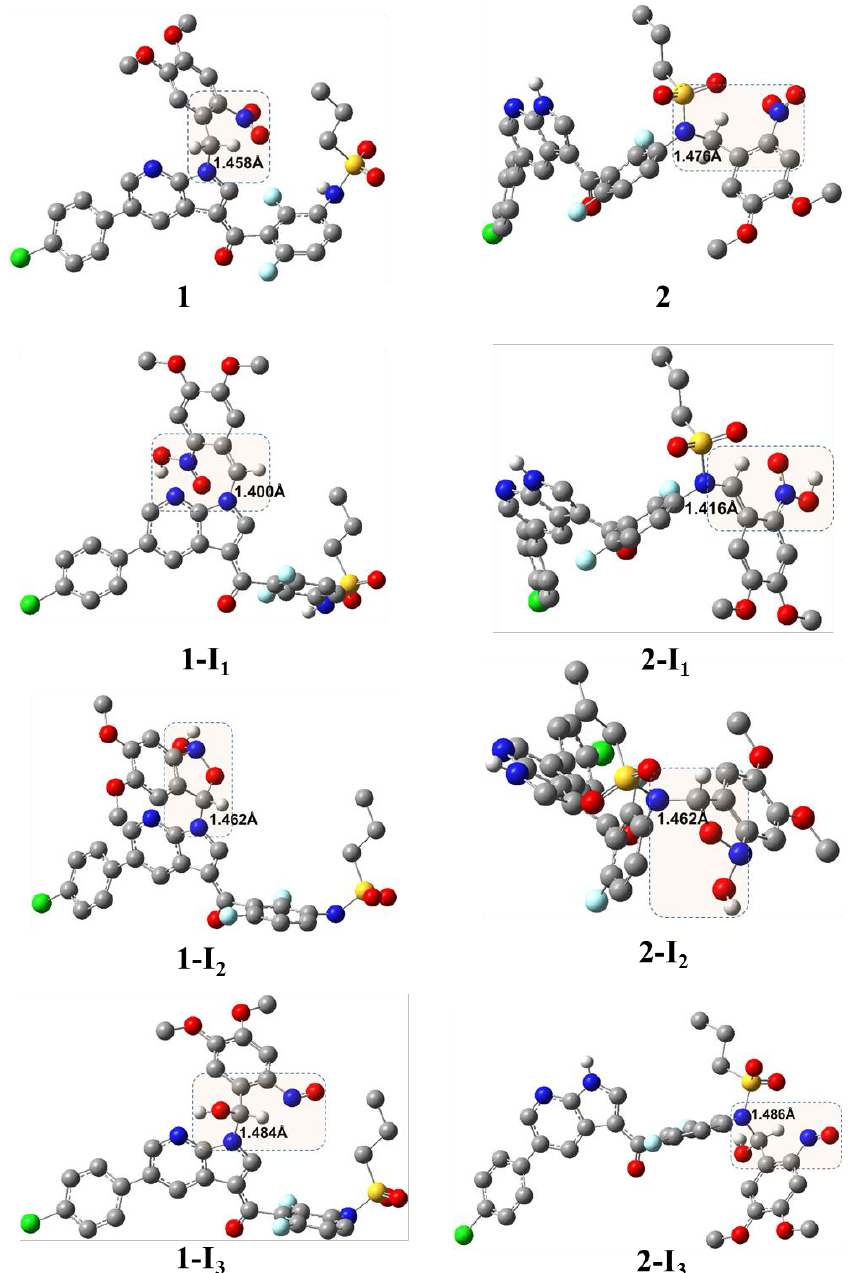
Figure 3. DFT/B3LYP/6-31+G(d)-optimized geometry of the DMNB-photocaged VFB and their corresponding photouncaging intermediates; uninvolved hydrogen atoms were omitted for clarity; highlighted regions indicate the center of the reaction; numbers indicate the bond length in Å .